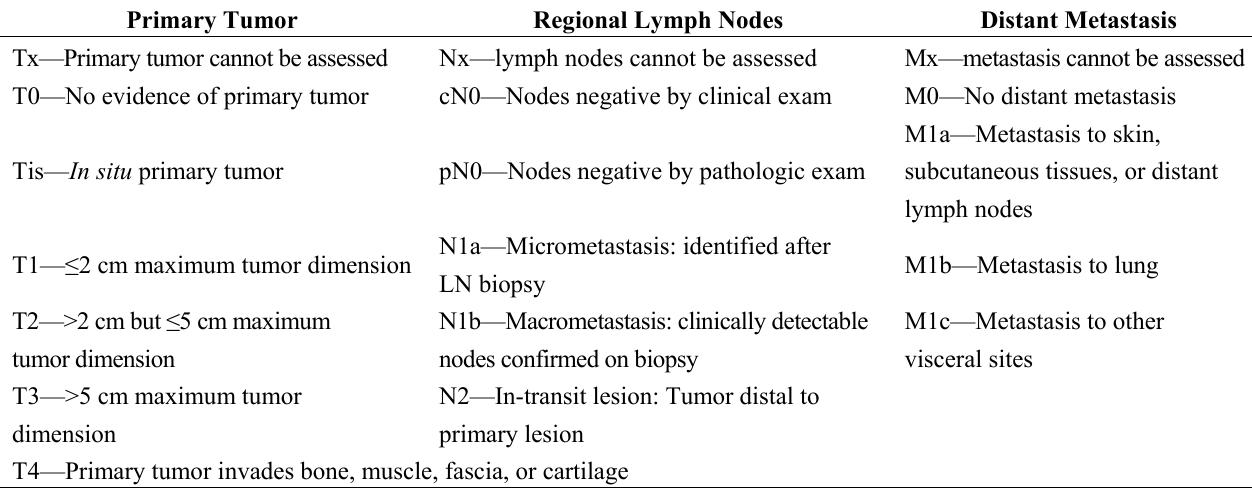
Table 1. AJCC 2010 TNM staging System for Merkel Cell Carcinoma [24].